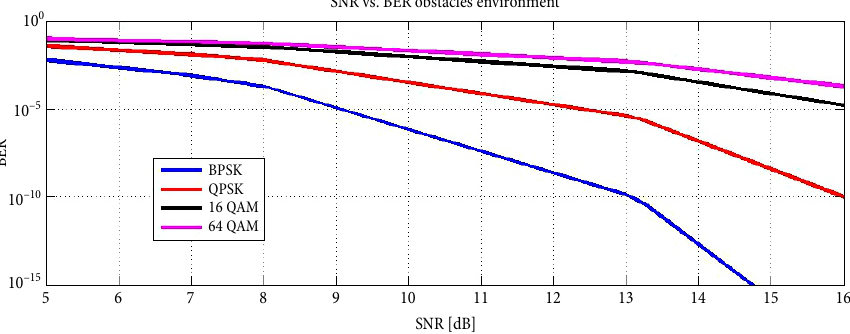
Fig. 10. Scenario with obstacles: SNR vs. BER for BPSK, QPSK, 16QAM,